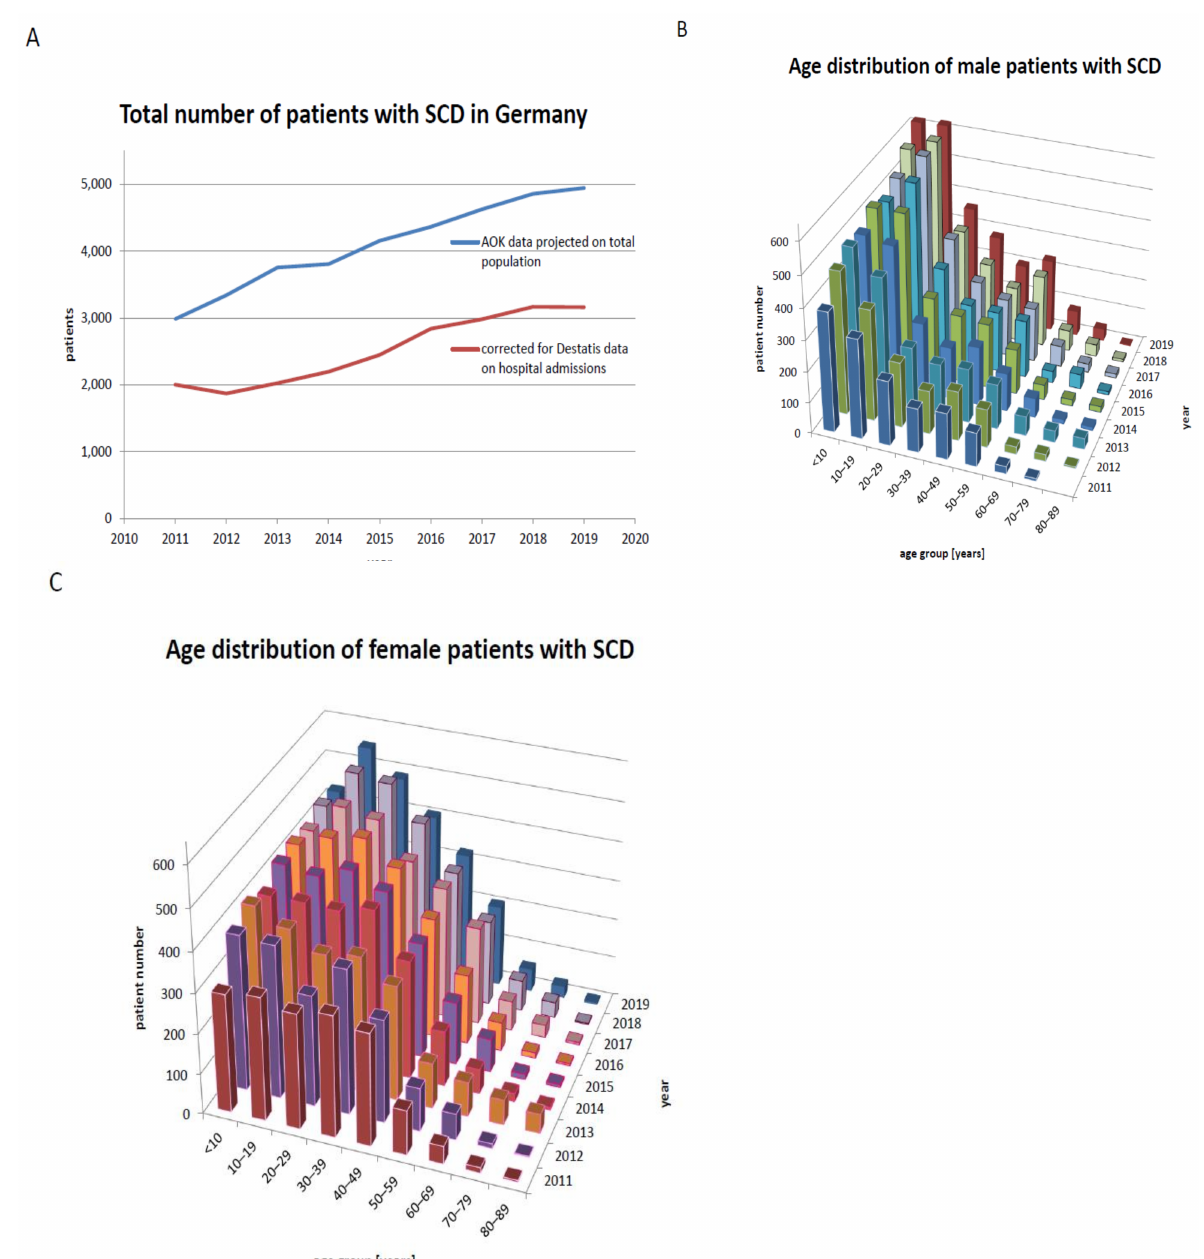
Figure 2. Number, sex and age of patients with SCD in Germany. ( A ) Estimated total number of patients with SCD in Germany based on AOK data and corrected by the Destatis data on hospital admissions, accounting for the suspected over- representation of migrants among those covered by AOK (see Supplementary Table S1 for correcting factors); ( B ) Distribution of age in male and ( C ) female patients with SCD